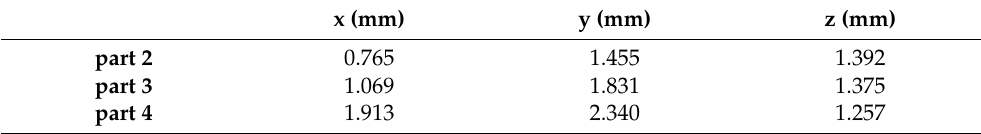
Table 5. Mean absolute error of transformed points using pointnet++ as a feature extractor and distance error loss for training where x, y, and z are transverse, anterior–posterior, and vertical distance error,